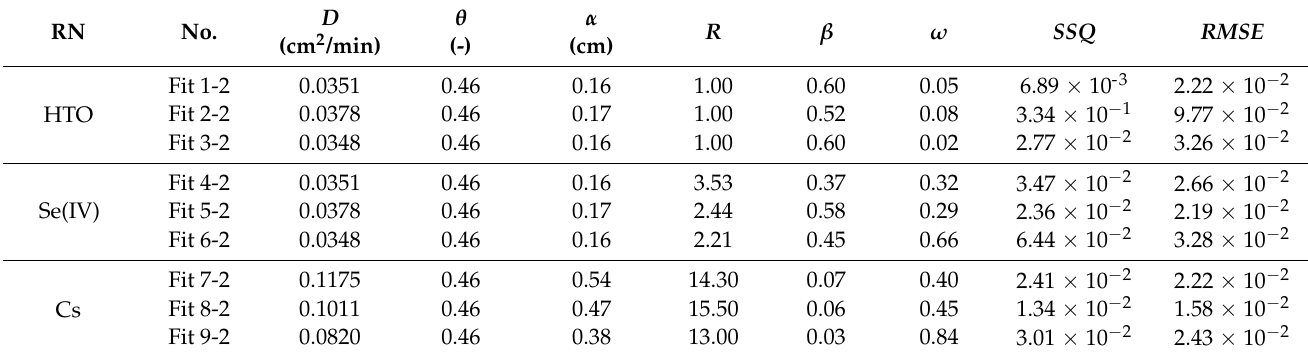
Table 3. The fitting parameters for HTO, Se(IV), and Cs for the physical non-equilibrium model. RN No.